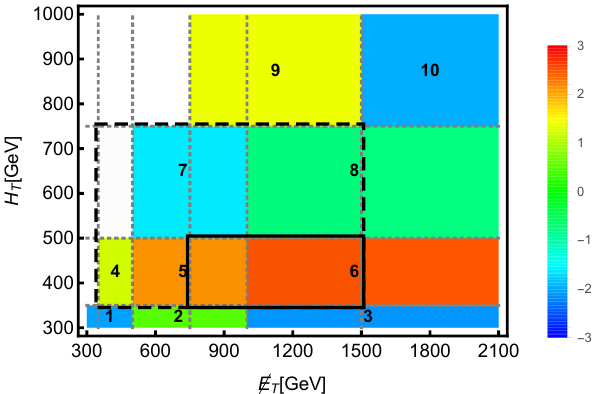
Figure 1 . The rectangular aggregation method with two kinematic variables on a particular set of 10 SRs from [13]. The colored rectangles represent individual signal regions, while the dotted gray lines illustrate the narrowest binning in each kinematic variable. The color-coding of each SR shows the pulls (in units of standard deviations) of a mock dataset which includes statistical (cid:13)uctuations and an injected signal, with red (blue) regions having upward (downward) (cid:13)uctuations with respect to the background. The black rectangles (solid and dashed) delimit two of the many possible choices of RAs. As described in the text, the SRs overlapping with a rectangle will be aggregated to form an